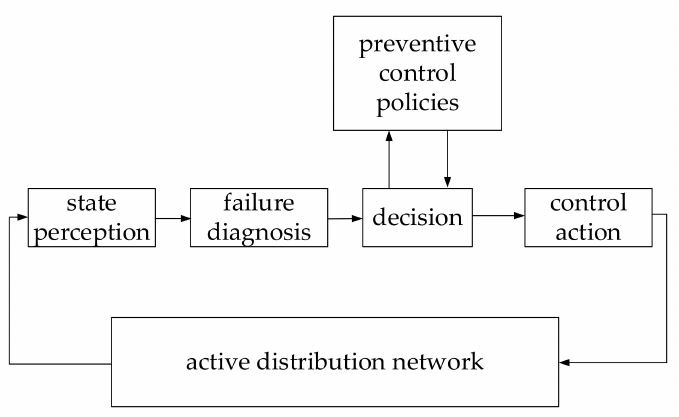
Figure 1. The preventive control process against cross-domain cascading failures (CCF) in an active distribution network